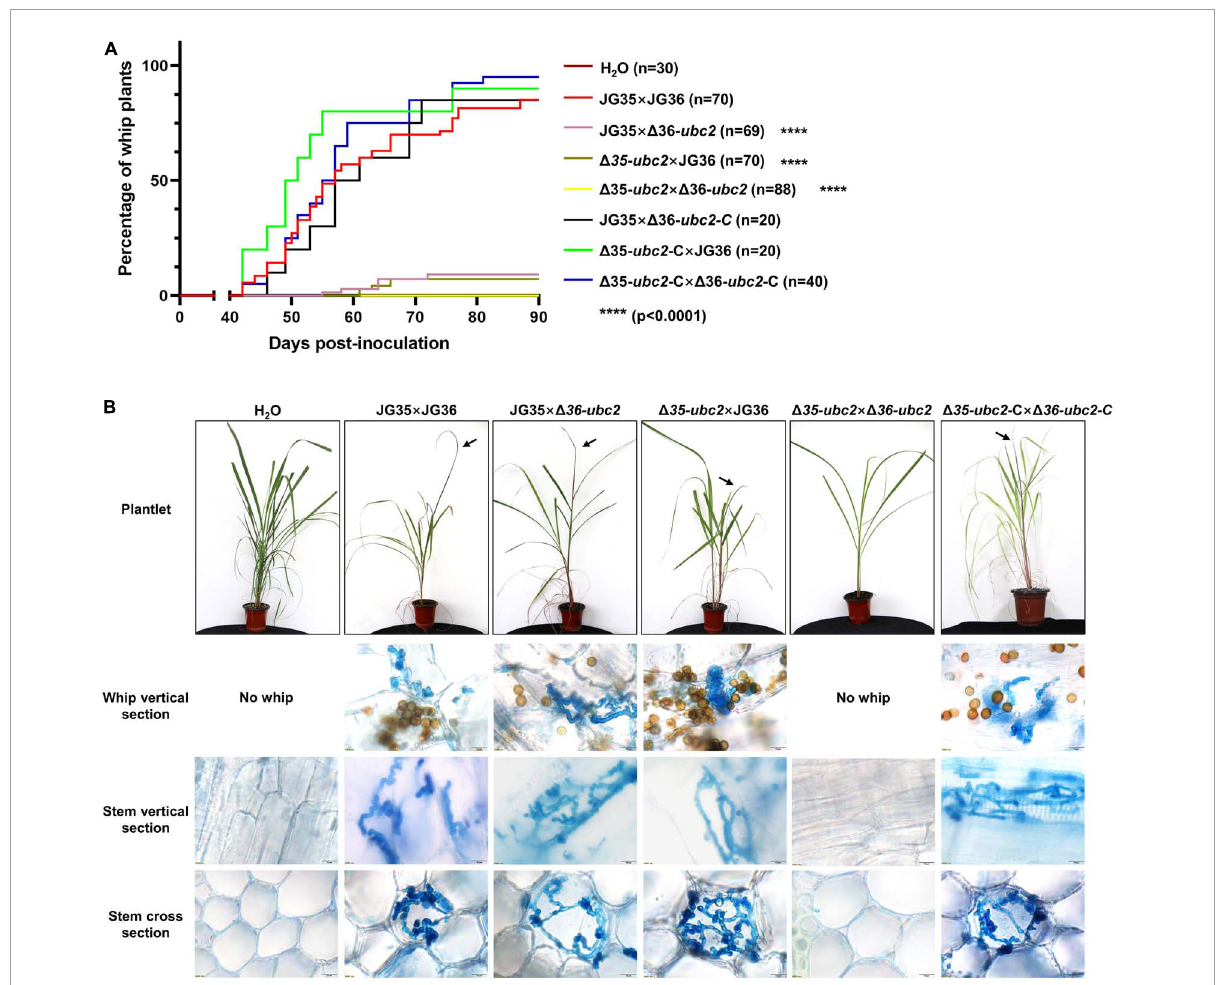
FIGURE4 The influence of Ssubc2 deletion on pathogenicity. (A) Progression of whip development induced by Ssubc2 deletion mutants and complementation strains. Sugarcane culture tissue-derived plantlets were inoculated with combinations of wild-type strains, (cid:49) Ssubc2 mutants, and/or complementation strains at a concentration of OD 600 = 1.0. Significance was set at p = 0.05. **** p < 0.0001. (B) Symptoms of plantlets inoculated with (cid:49) Ssubc2 mutants or wild-type strains. Arrows indicate whips. Histopathology of the plantlets was performed by dissecting the plantlets and staining them with 0.4% trypan blue. No hyphae were detected in plantlets inoculated with H 2 O or (cid:49) 35- ubc2 × (cid:49) 36- ubc2 . Scale bar, 20 µ